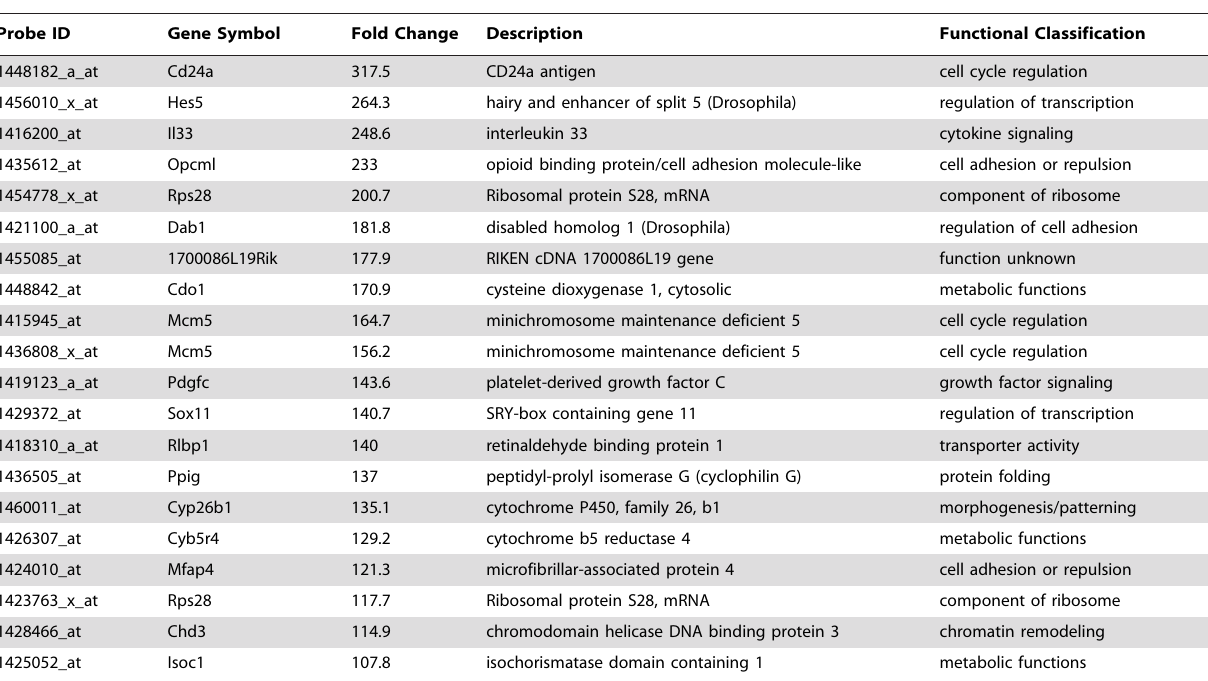
Table 1. Top 20 probe-sets showing largest fold-difference in expression (P6 .